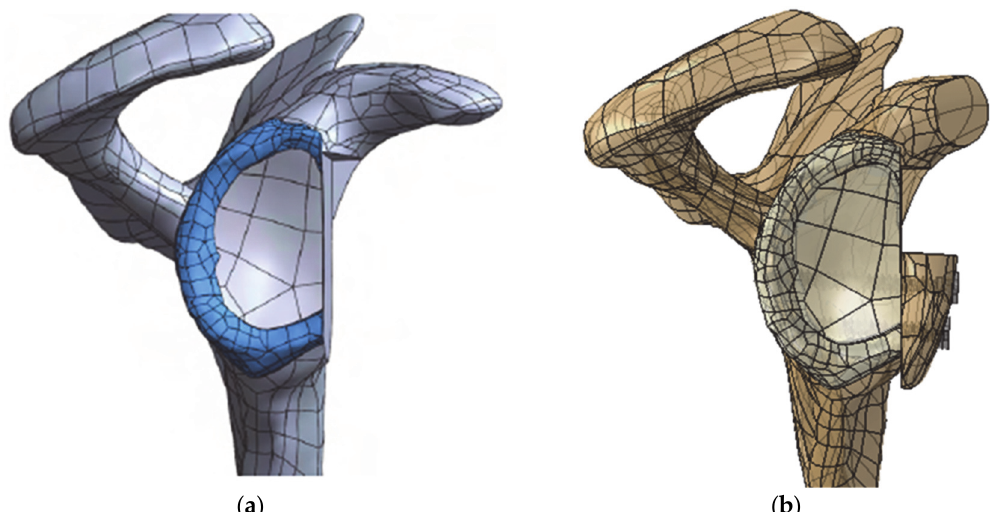
Figure 1. 3D geometry of the scapula illustrating ( a ) the 20% glenoid bone defect simulated and ( b ) the Latarjet procedure with the bone graft in the reference position.